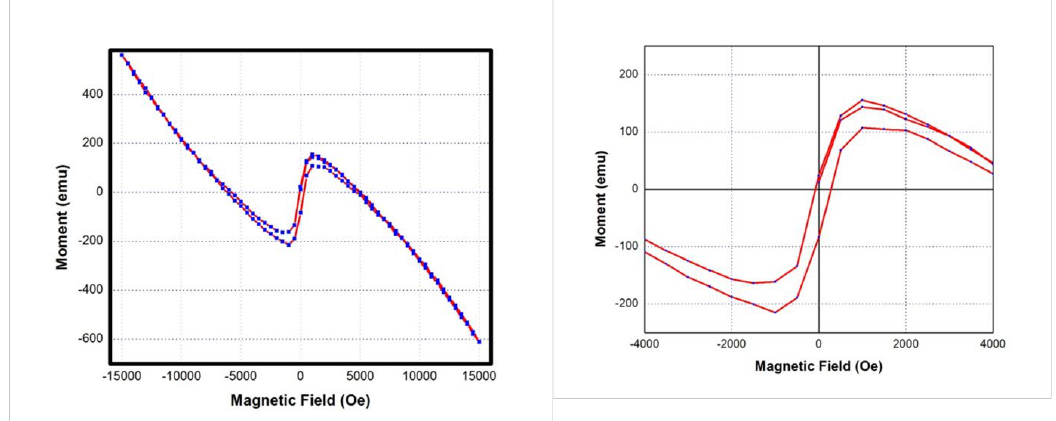
Fig. 8. VSM analysis of ZrO2